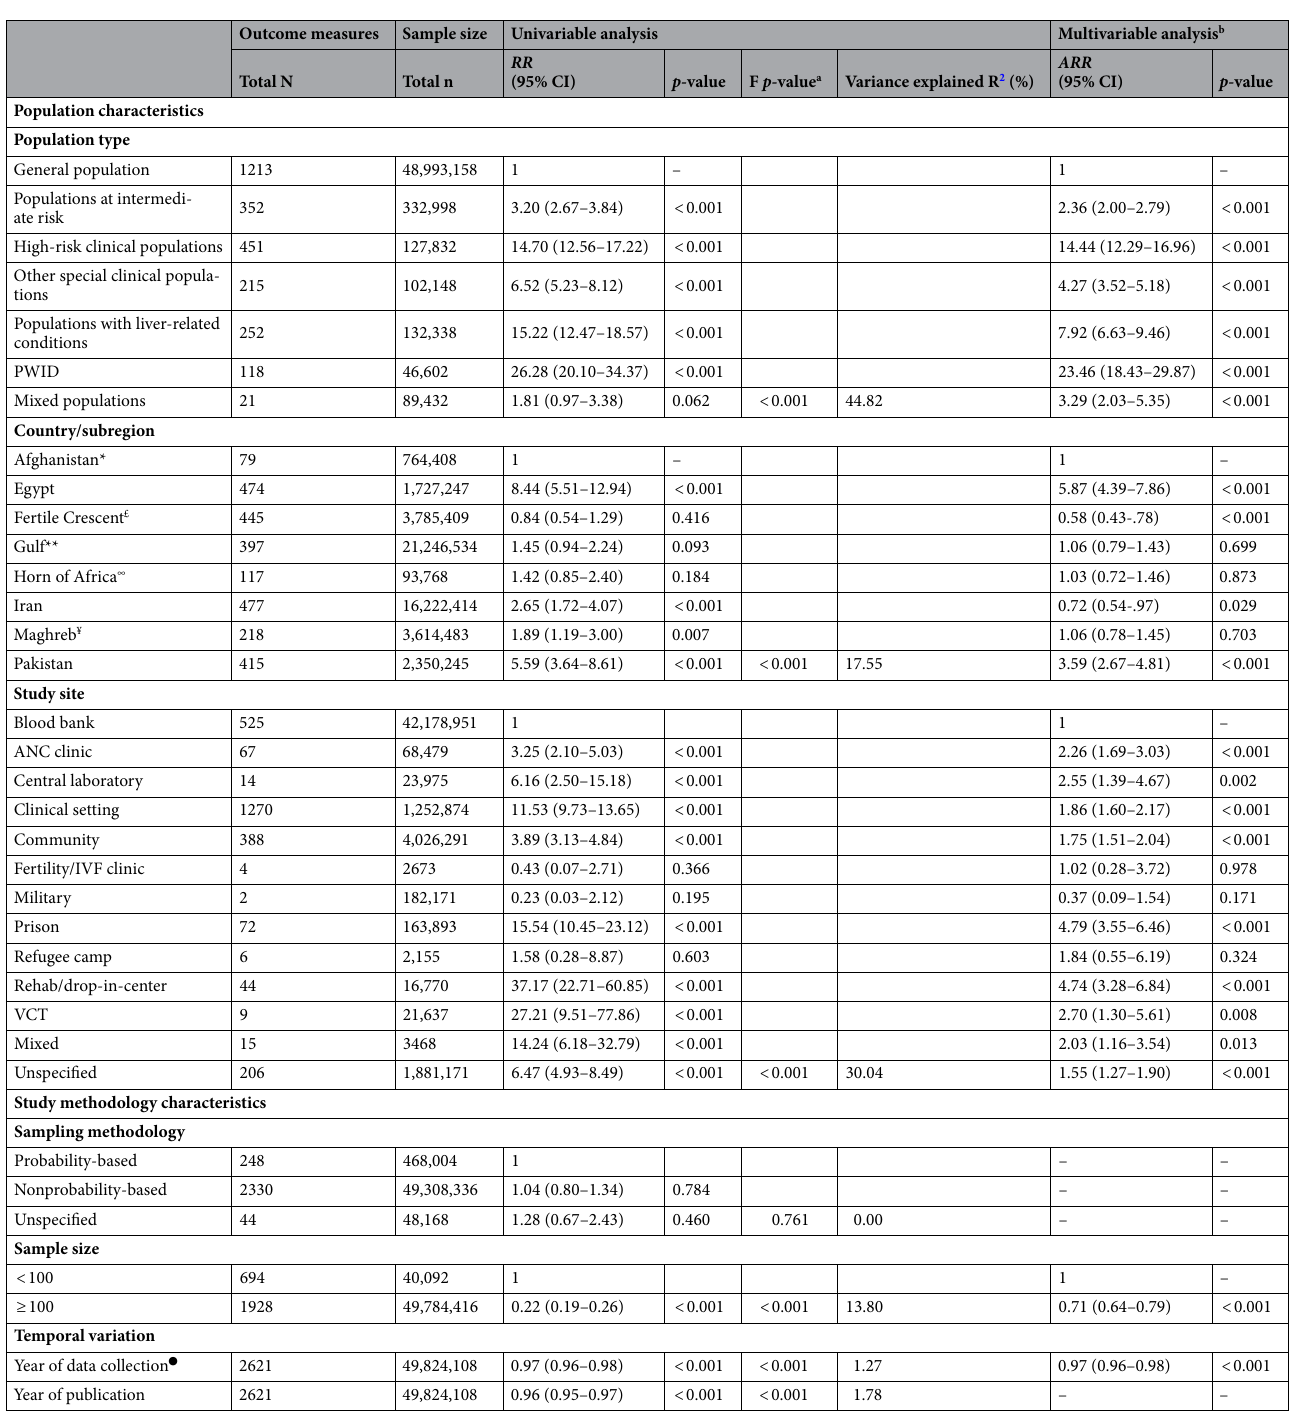
Table 2. Univariable and multivariable meta-regression analyses for HCV Ab prevalence in all populations in the Middle East and North Africa. Abbreviations: Ab, antibody; ANC, antenatal care; ARR, adjusted relative risk; CI, confidence interval; HCV, hepatitis C virus; IVF, in vitro fertilization; PWID, people who inject drugs; RR, relative risk; VCT, voluntary counseling and testing. *Afghanistan was chosen as a reference country given the availability of considerable number of studies in the general population, low HCV prevalence in the general population, and being the first country alphabetically to qualify accordingly. £ Countries include Iraq, Jordan, Lebanon, Palestine, and Syria. **Countries include Bahrain, Kuwait, Oman, Qatar, Saudi Arabia, and United Arab Emirates. ∞ Countries include Djibouti, Somalia, Sudan, and Yemen. ¥ Countries include Algeria, Libya, Mauritania, Morocco, and Tunisia. ● Due to collinearity between year of data collection and year of publication, the multivariable analysis included only one of these variables, year of data collection. a Variables with a p-value ≤ 0.2 were eligible for inclusion in the multivariable analysis. b The adjusted R-squared for the full model was